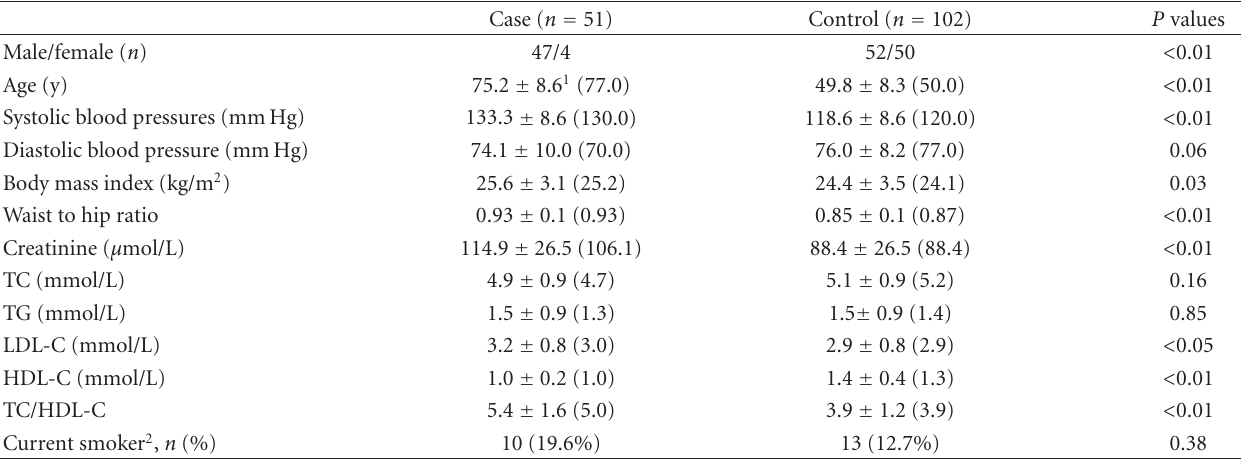
Table 1: Characteristics of subjects.